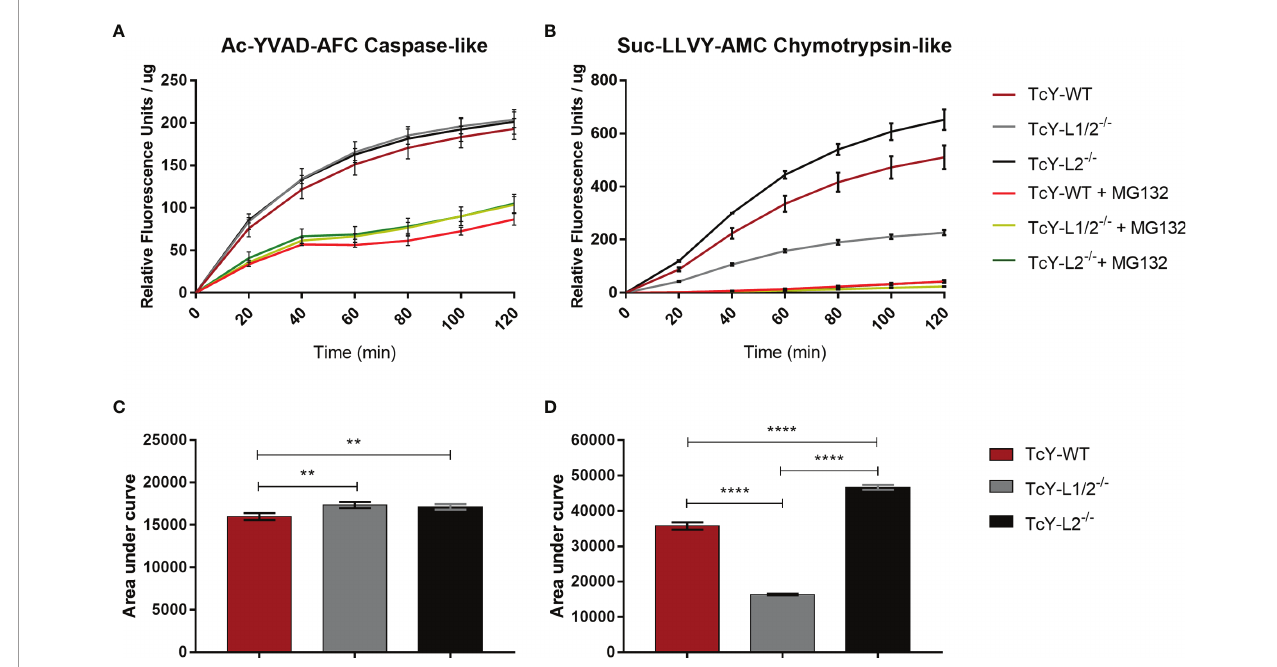
FIGURE 6 | Cysteine protease and serine protease enzymatic activity kinetics. Cysteine (A) or serine (B) activity in TcY-WT, TcY-L1/2 − / − , or TcY-L2 − / − trypomastigotes protein extracts were assayed using a fl uorescence method with caspase substrate Ac-YVAD-AFC for caspase-like cysteine enzyme activity or chymotrypsin substrate Suc-LLVY-AMC for chymotrypsin-like serine enzyme activity. The data are mean±SD for the kinetic curves (A, B) (**p < 0.01, ****p < 0.0001, one-way ANOVA, Fisher ’ s LSD).